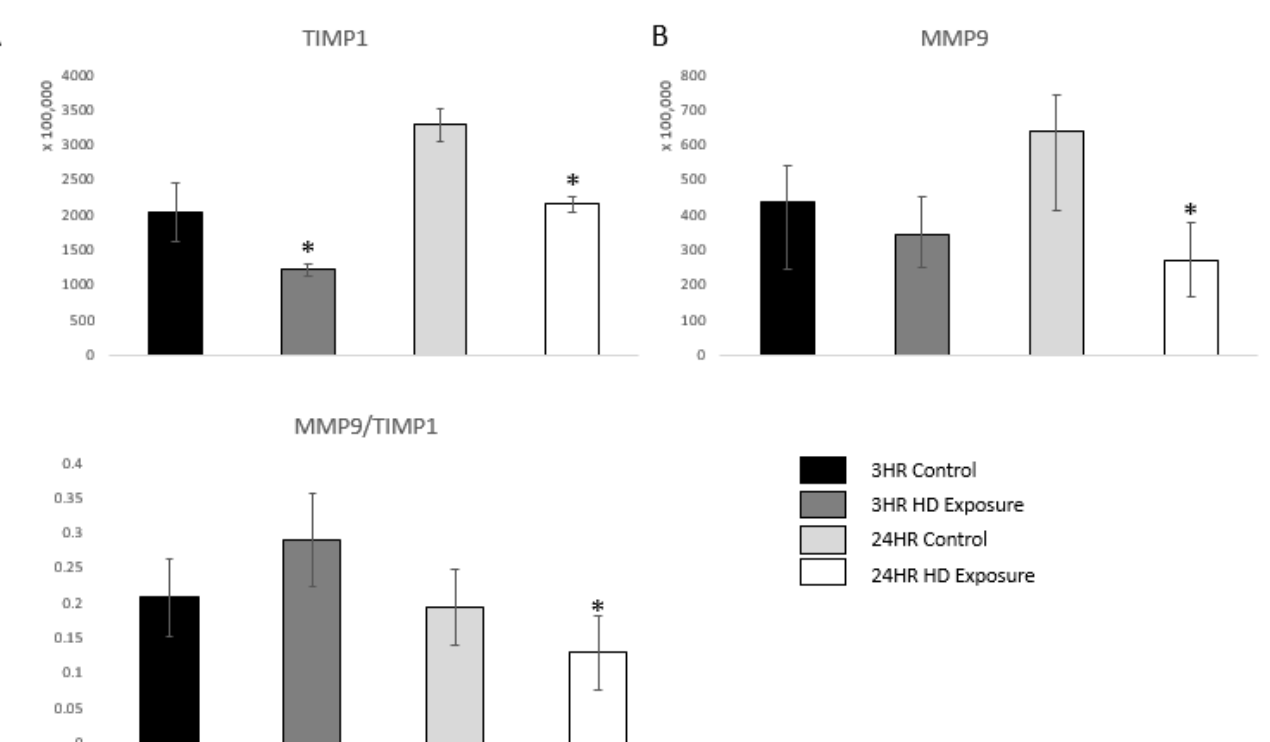
Figure 6. Bar graphs of the normalized abundances of ( A ) TIMP1 expression profile across the control groups, 3 h and 24 h exposures, ( B ) MMP-9 at the 3 h and 24 h marks, and ( C ) Ratios between the expression levels of MMP-9 vs. TIMP1. Significant dysregulation of TIMP1 and MMP9 (adj. p -value ≤ 0.05) is shown by * and significant changes in the ratio ( p -value ≤ 0.05, students t -test) are indicated by *.